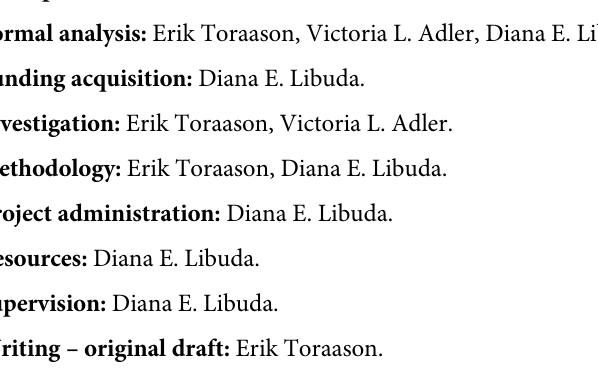
S7 Data. Associated with S3 Fig. Region of wild type young and aged germlines which is stained with DSB-2. Each row represents a single quantified germline. Columns indicate the age and mated status of the germline (Age; Young = 1 day post L4, Aged = 4 days post L4), the gonad number (GonadID), the beginning of DSB-2 staining in germline distance normalized to pachytene (DSB2_start, see methods), the end of DSB-2 staining in germline distance nor- malized to pachytene (DSB2_end, see methods), and the position of the most proximal DSB-2 staining nucleus in germline distance normalized to pachytene (DSB-2_straggler, see